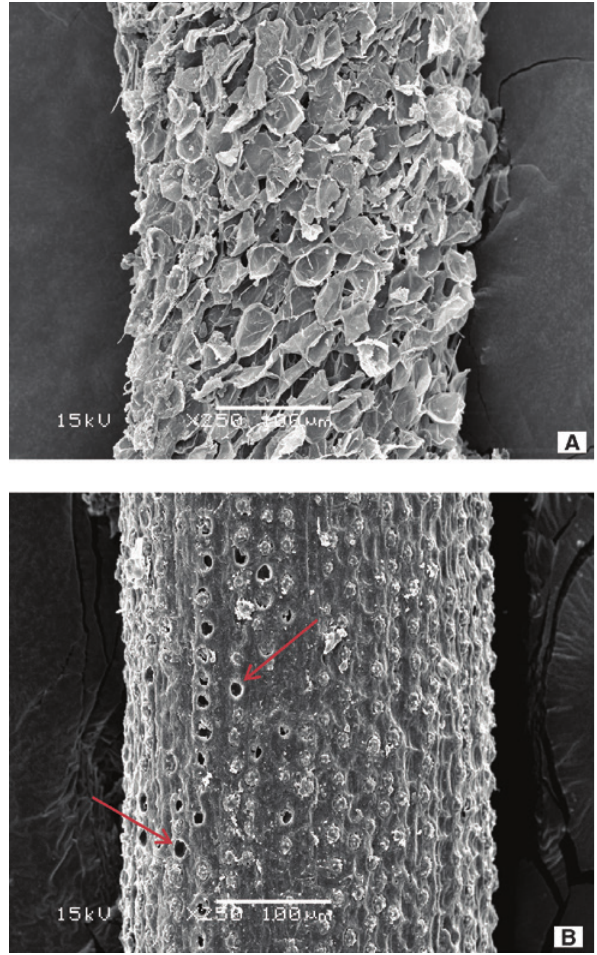
Figure 1: MEB micrographs of (A) non-treated and (B) 1% NaOH-treated date palm